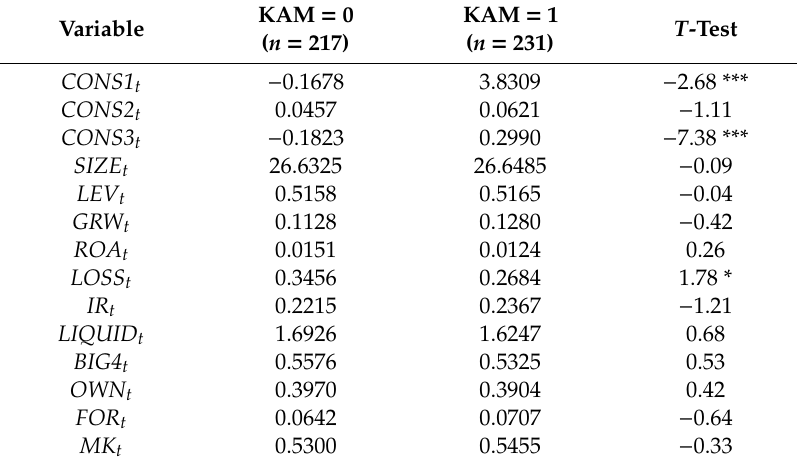
Table 4. Univariate Results ( n =